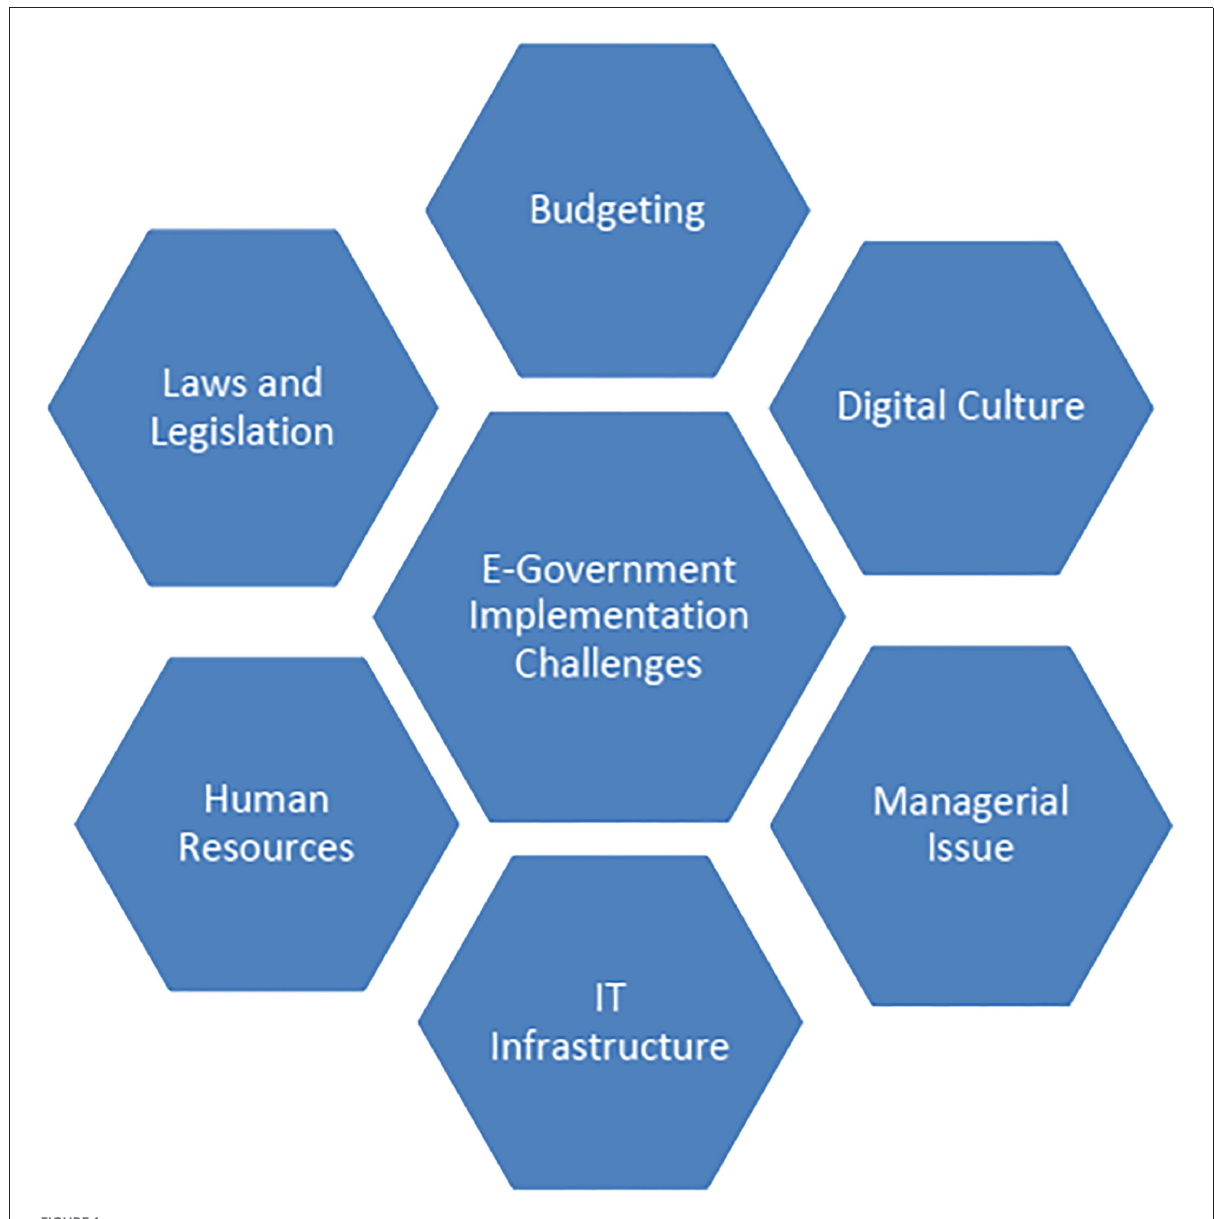
FIGURE1 Challenges of e-government